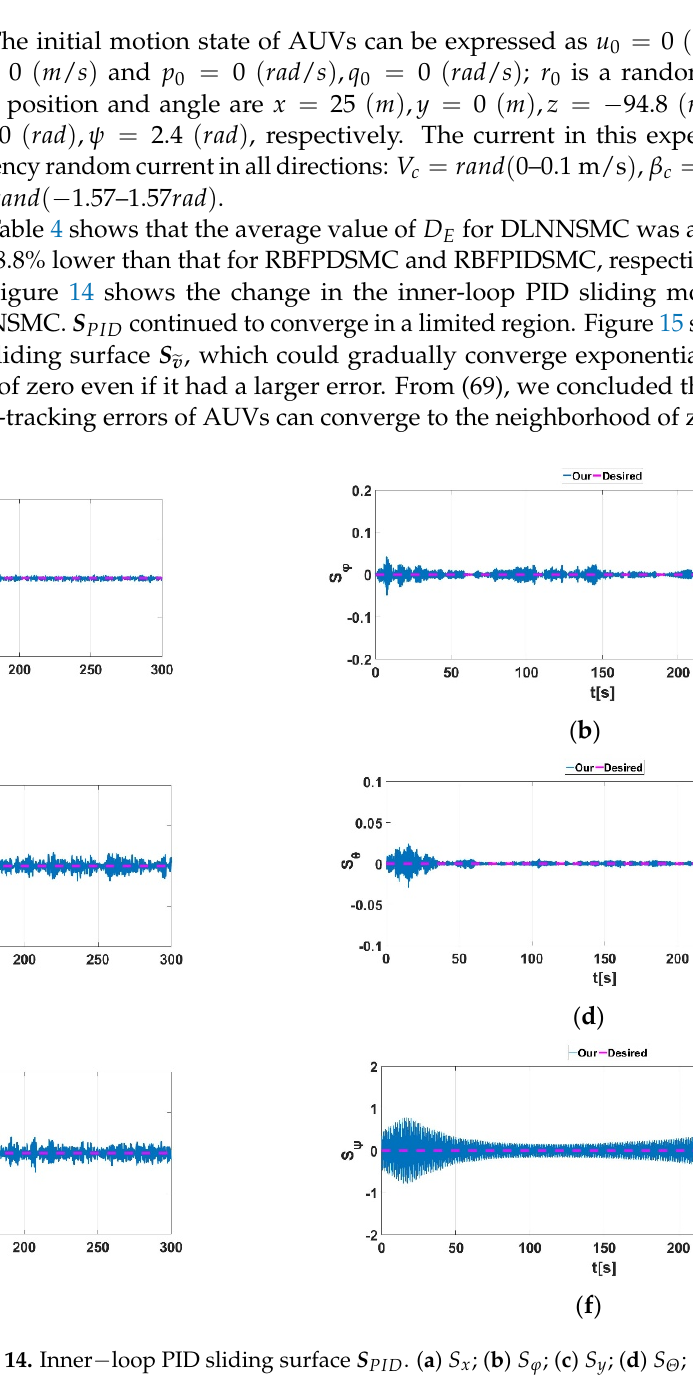
; ( c ) 𝑣 𝑒 ; ( d ) 𝑞 ; ( e ) 𝑤 𝑒 ; ( f ) 𝑟 𝑒 . 𝑒 𝑒